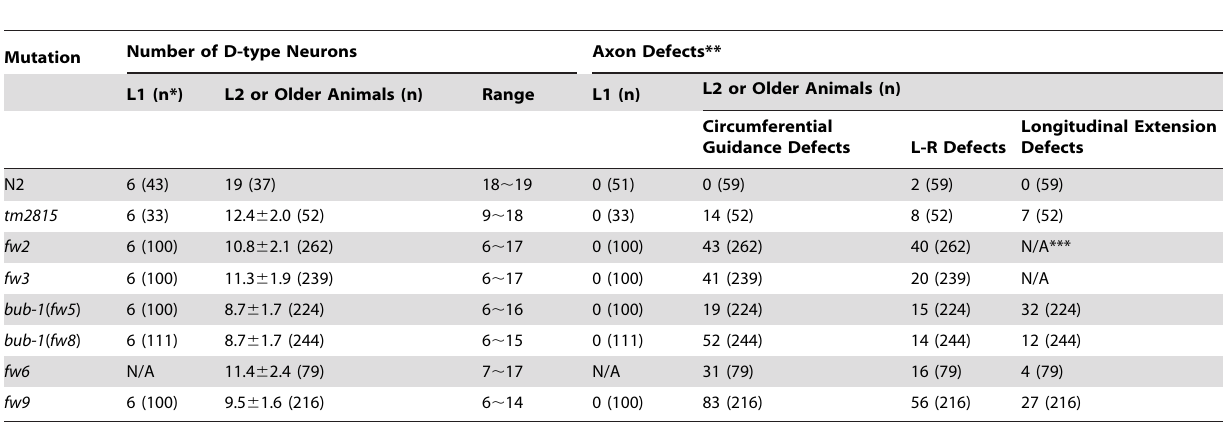
Mutation Number of D-type Neurons Axon